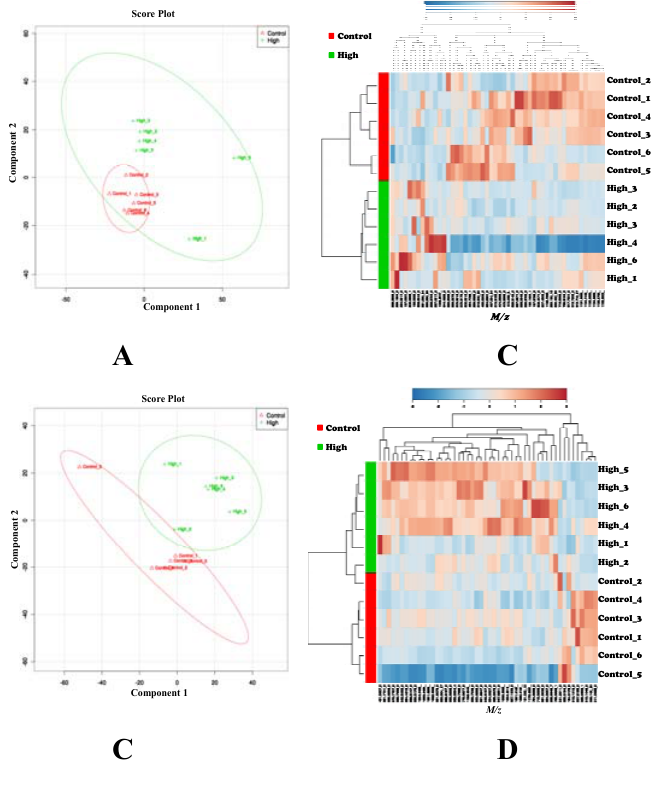
Figure 1. Partial Least Square-Discriminant Analysis (PLS-DA) plot ( A , B ) and unsupervised hierarchical clustering plot ( C , D ) for control and high dose groups (male animals). (A, C) positive ionization mode; (B, D) negative ionization mode; a heat